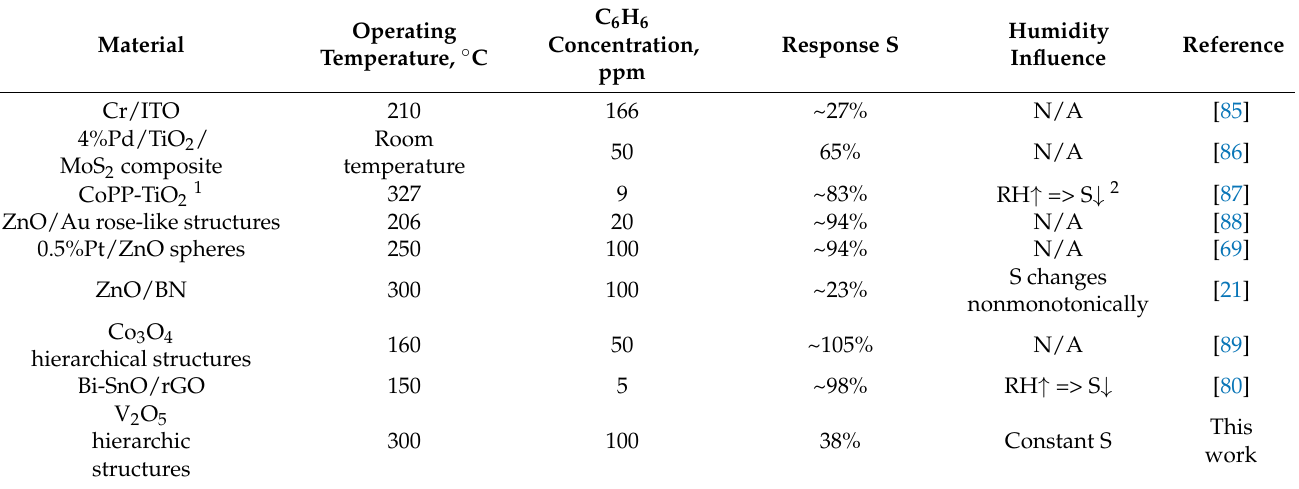
Table 1. Comparison of benzene gas sensing properties of prepared V 2 O 5 film and several previously reported